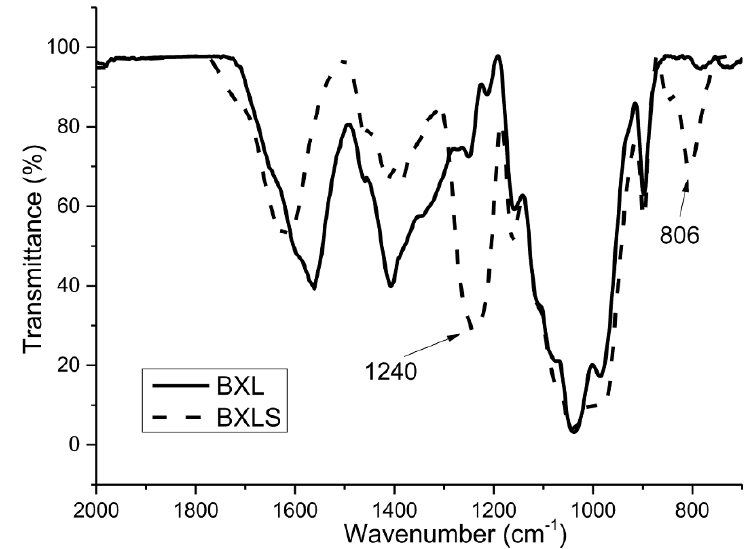
Figure 1. FTIR spectra of non-sulfated (BXL) and sulfated (BXLS) glucuronoxylan samples.